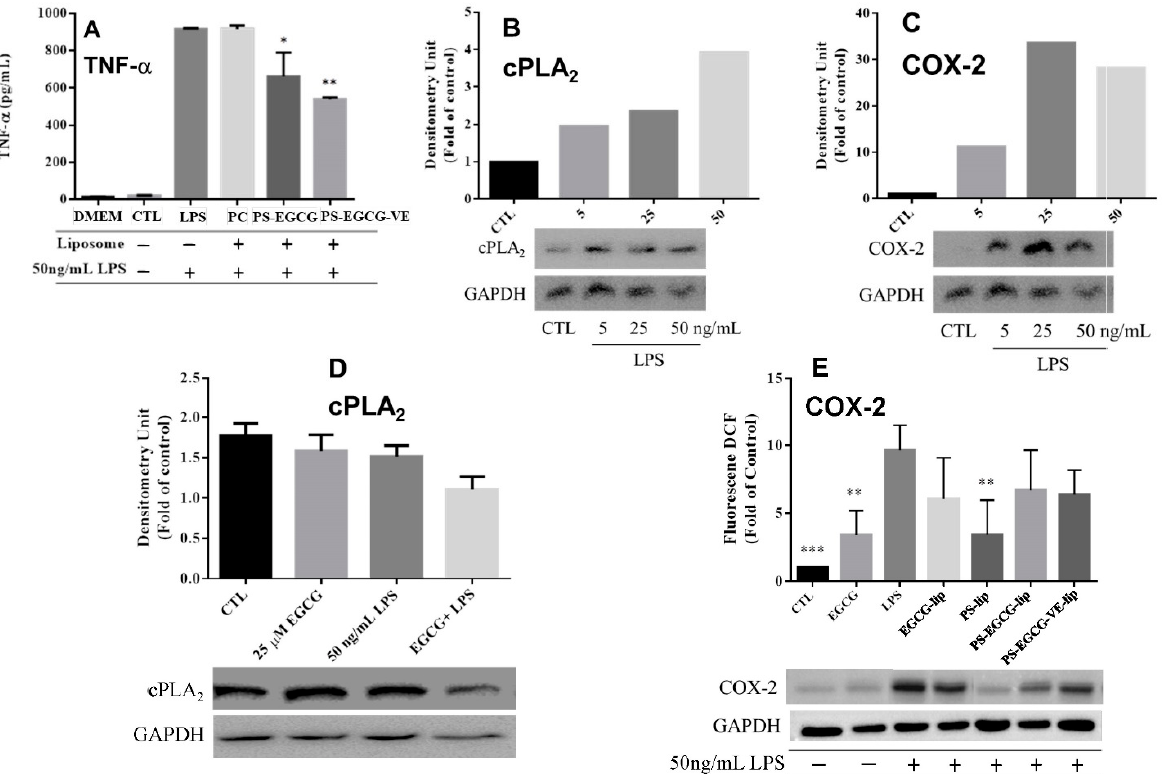
Figure 4. In LPS-induced BV-2 cells, expression of ( A ) TNF- α (compared with the liposome ( − ) and LPS (+) group, * p < 0.05; ** p < 0.01, n = 3), ( B ) cytosolic phospholipase A2 (cPLA 2 ), and ( C ) cyclo-oxygenase-2 (COX-2). In BV-2 cells pretreated by EGCG or liposomes and then induced by LPS, expression of ( D ) cPLA 2 and ( E ) COX-2 (compared with LPS (+) group ** p < 0.01, *** p < 0.001, n = 3).